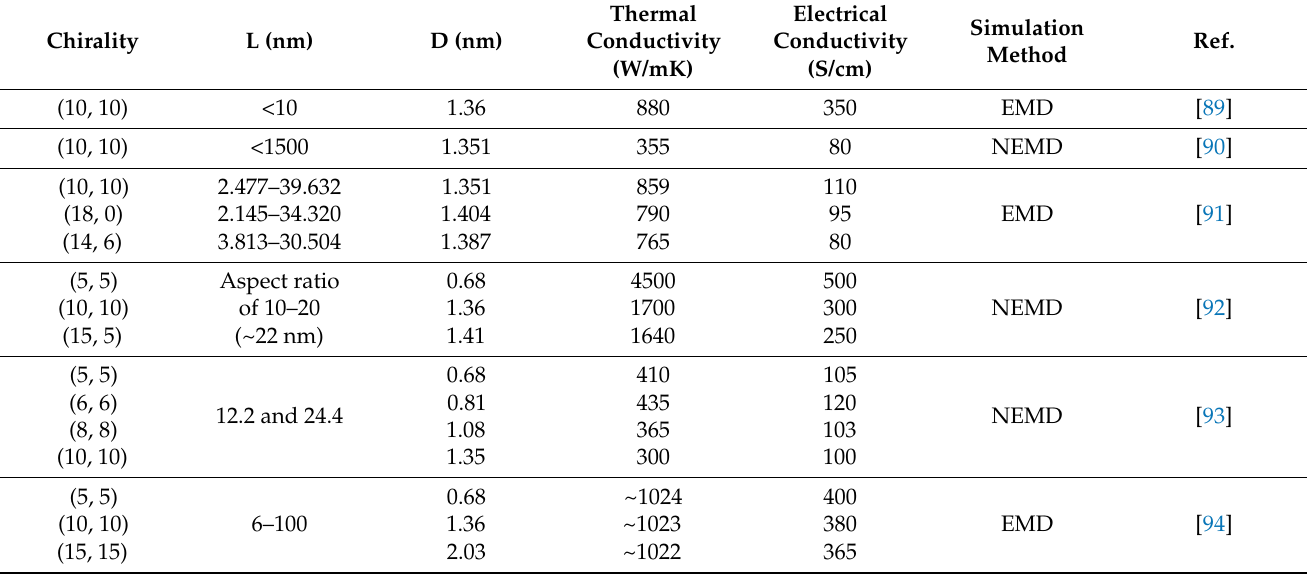
Table 4. Summary of MD simulations of thermal conductivity values at room temperature for the maximum length and different